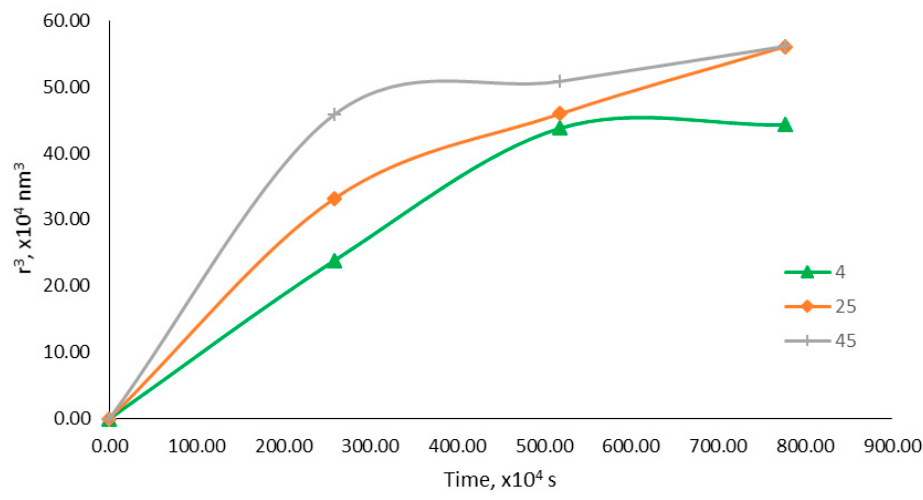
Figure 6. Graph of r 3 versus storage time (sec).